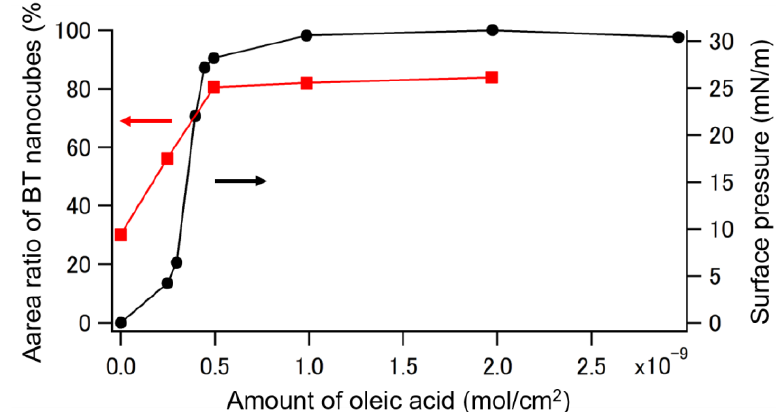
Figure 5. Surface pressure on the water subphase surface (black filled circles and solid line) and mean area ratio of BT nanocube in a 1.6 µ m × 1.9 µ m area on the substrate (red filled squares and solid line) plotted against the amount of oleic acid added to the water surface.